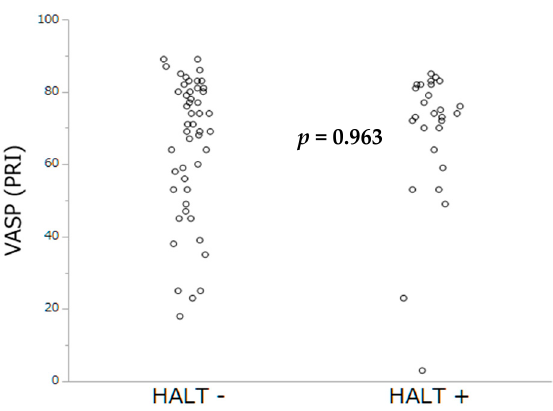
Figure 6. Occlusion time by VASP according to the occurrence of HALT. Table 7. HALT at 30-day and 1-year follow-up.